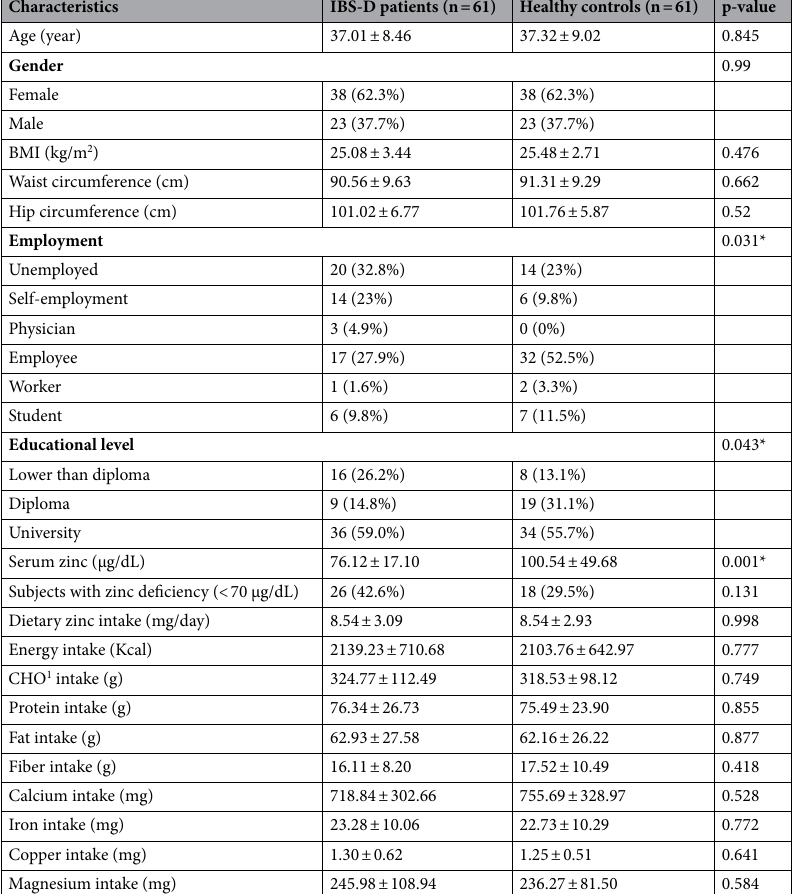
Table 1. General characteristics of the study groups. 1 Carbohydrate. Data are presented as mean (standard deviation) or frequency (%). Independent sample t-test was used for comparison of quantitative variables. Chi- square test was used for comparison of qualitative variables. *p-value <